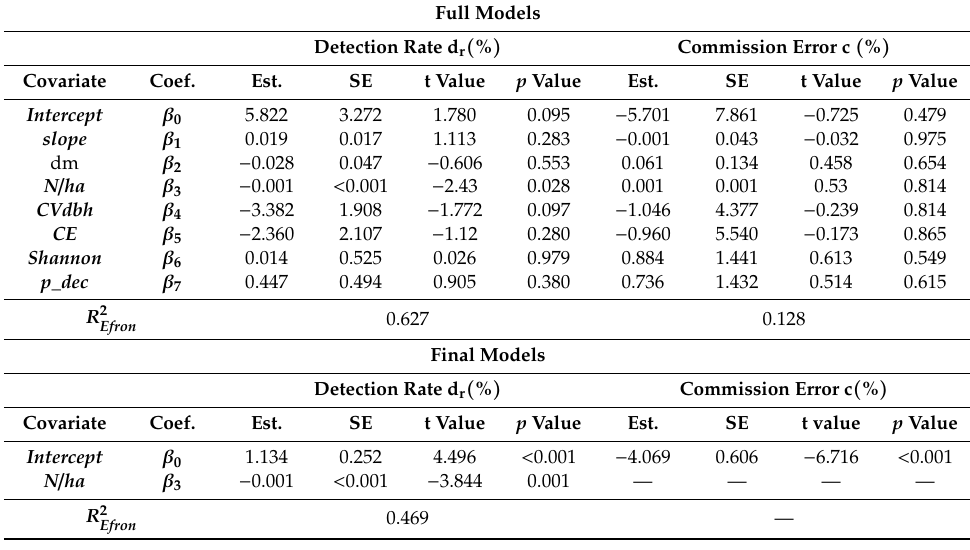
Table 6. Logistic regression analysis.